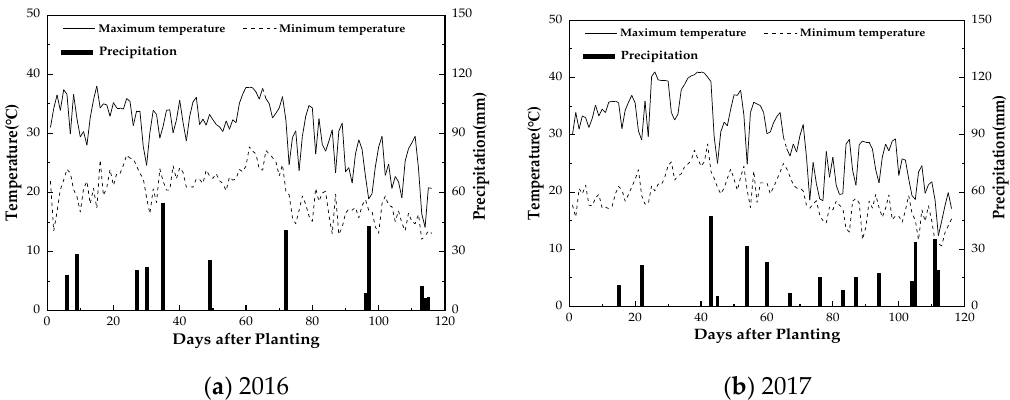
Figure 2. Daily temperature and precipitation in the Wugong County during entire summer maize growing seasons.